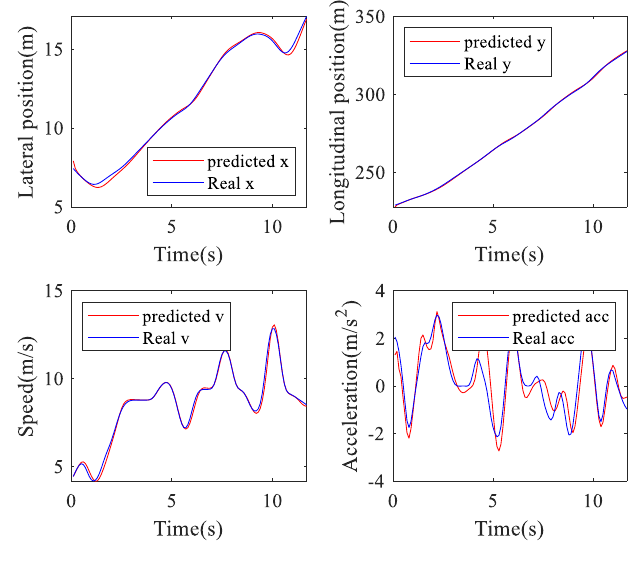
Figure 13. Turn right prediction.